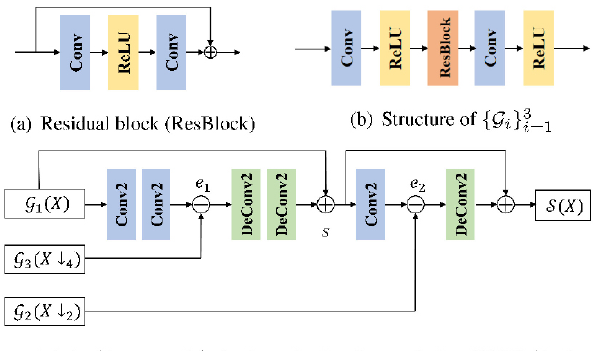
Fig. 1 (a) Structure of the residual block (ResBlock). (b) {G i ( · ) } 3 in FDM share a common architecture of a CNN with different parameters to be learned. (c) Structure of the BPFF block. Conv2 and DeConv2 represent a convolutional layer and deconvolutional layer with stride of 2